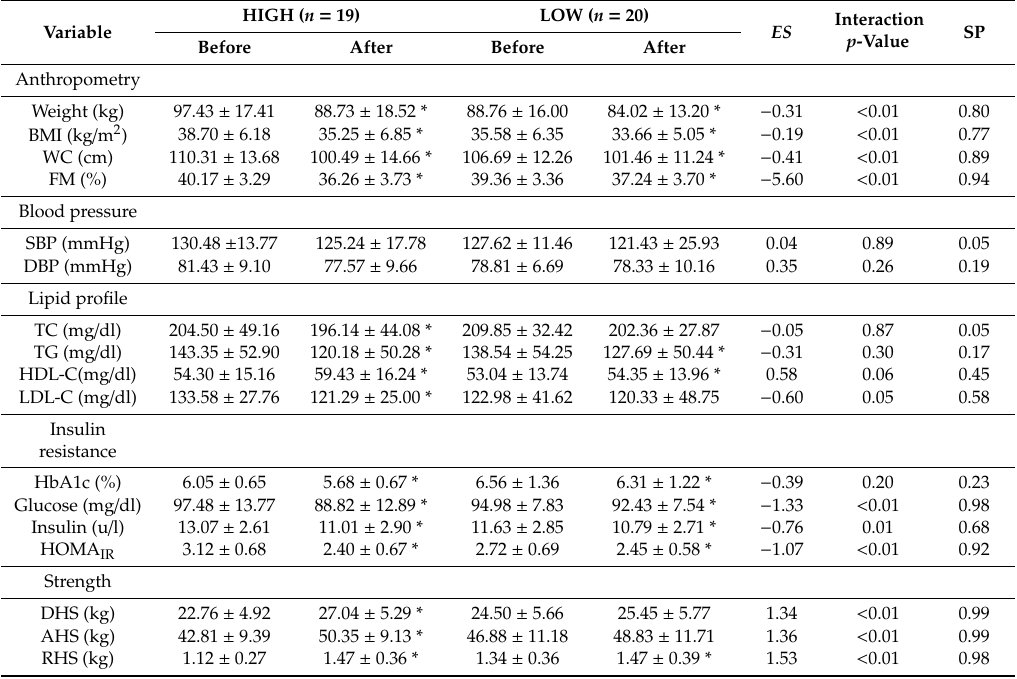
Table 2. Participant characteristics before and after the 24 weeks of